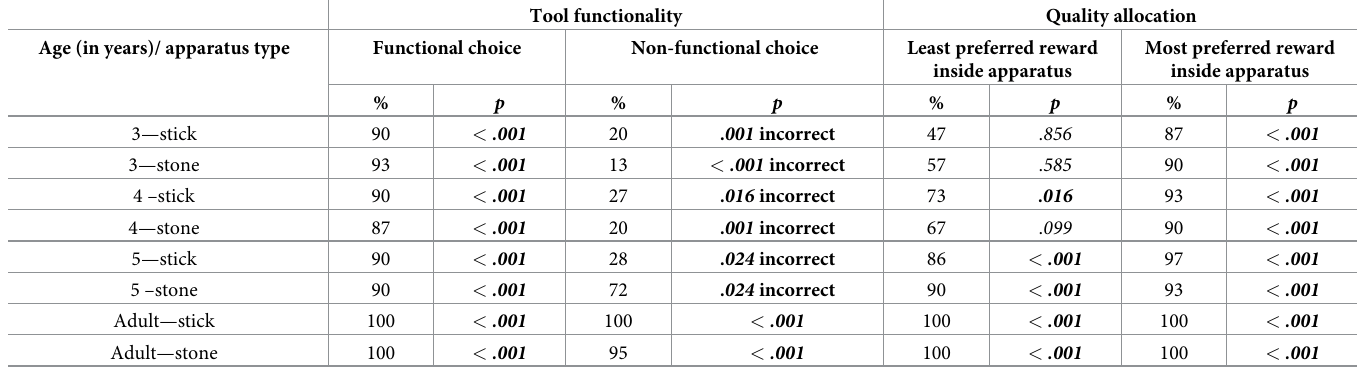
Table 3. Correct choices (%) in tool functionality and quality allocation conditions in each apparatus type for children aged 3–5 years and adult humans. P-values calculated from exact two-tailed binomial tests. NS = not significant with a Bonferroni correction. Significant p-values are highlighted in bold. “Incorrect”–selected incor- rect choice above